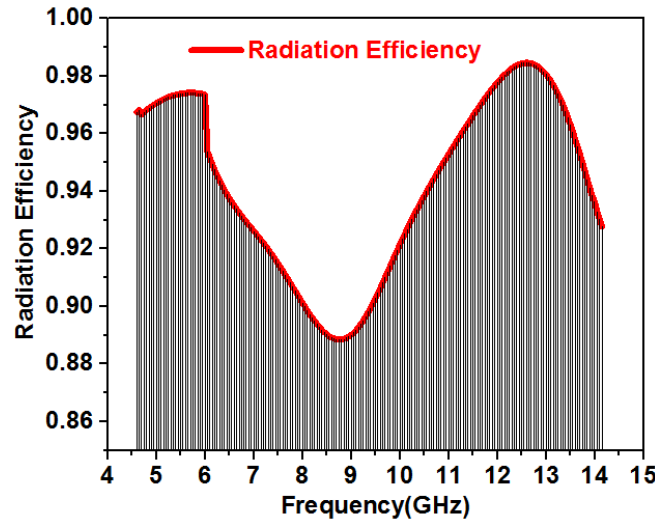
Figure 33. The efficiency of the proposed antenna.